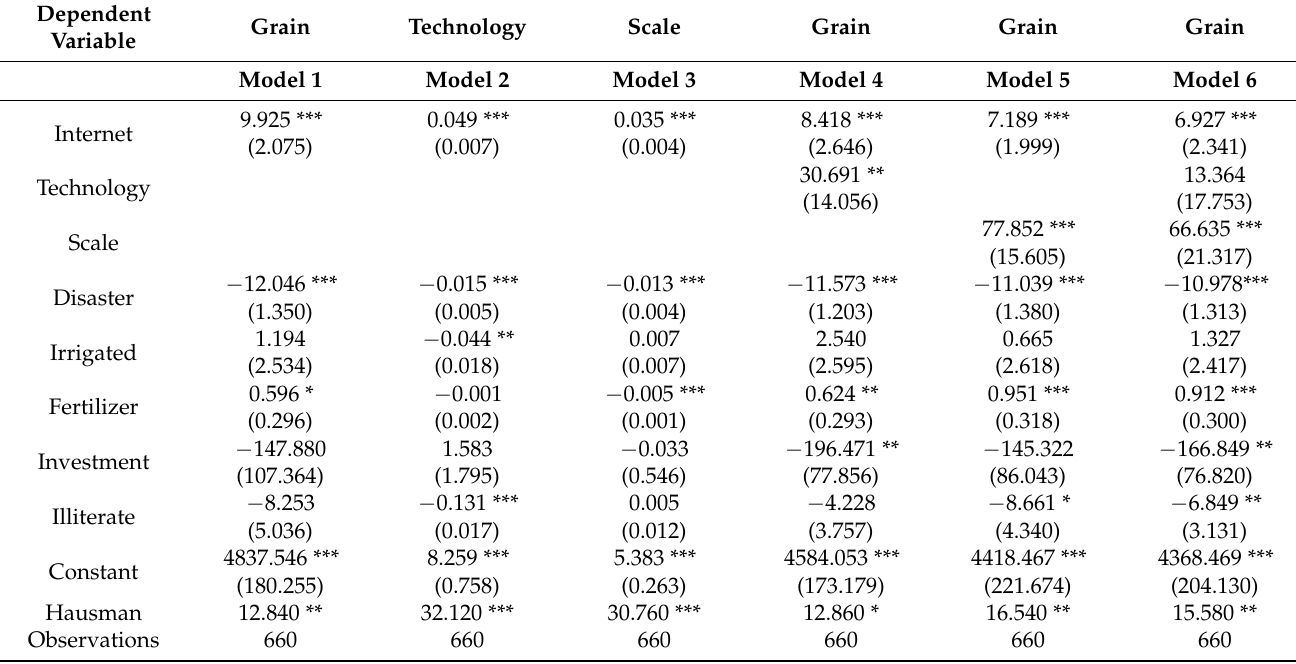
Table 3. The result of the mediation